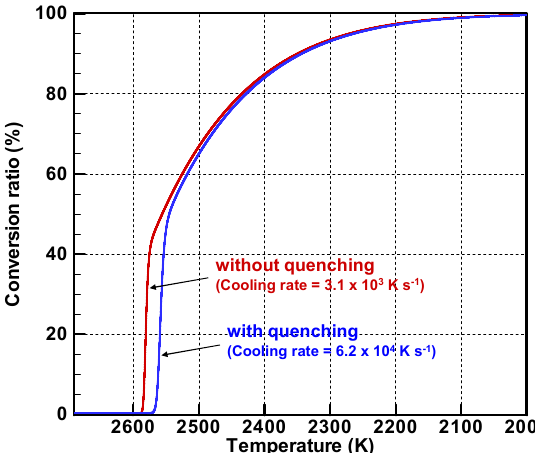
Figure 7. Evolutions of conversion ratios.